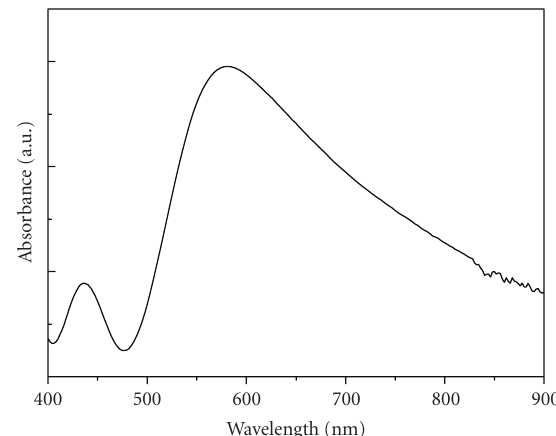
Figure 4: UV-Vis absorbance spectrum of an electrodeposited POT